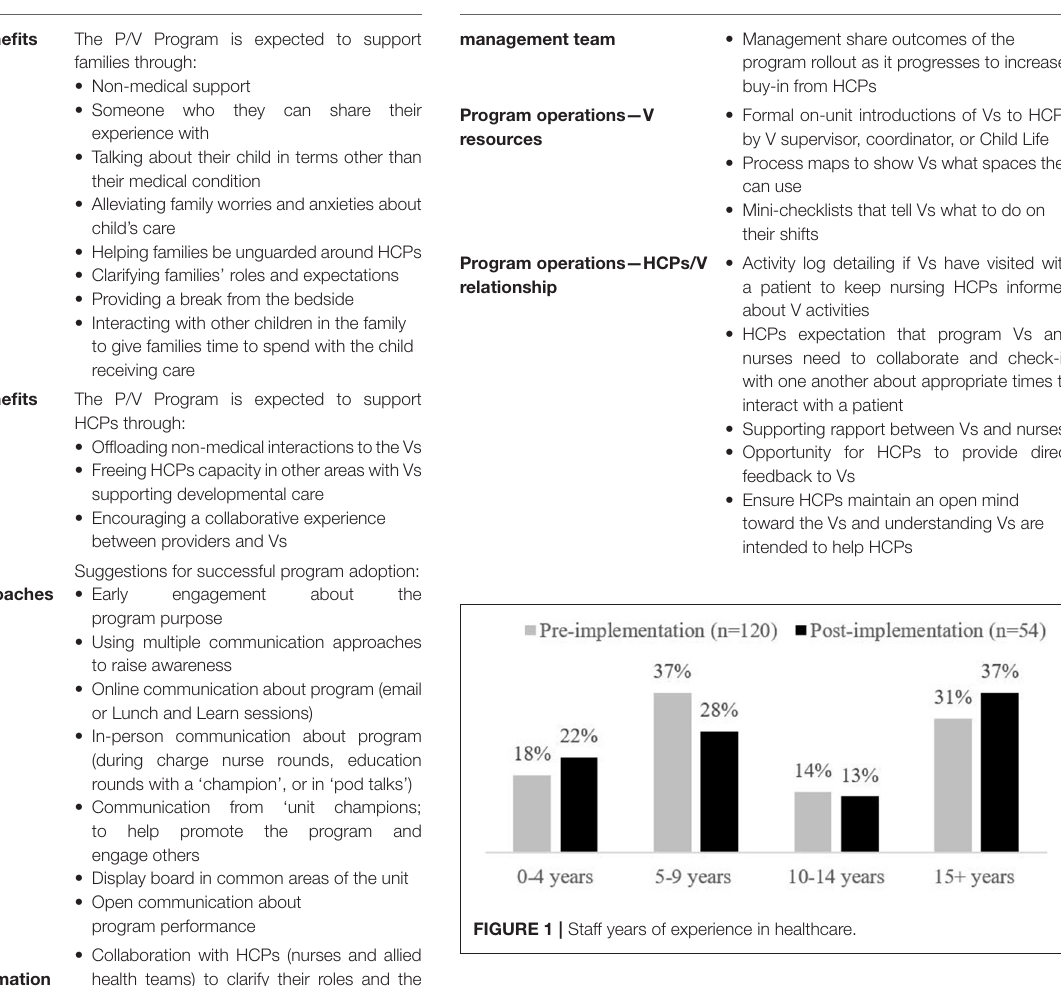
TABLE 2 | HCPs focus group themes (pre-implementation). Theme